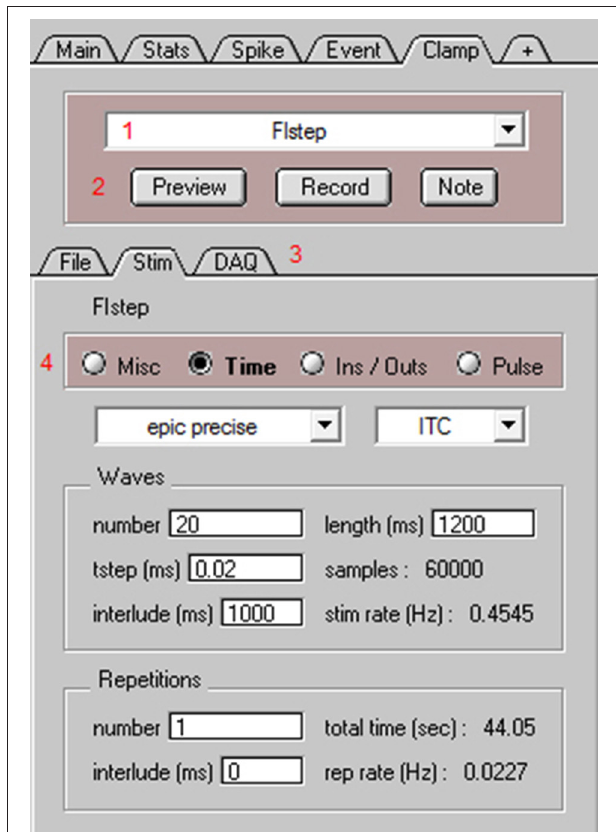
FIGURE 6 | NeuroMatic’s Clamp tab for data acquisition. Screen capture of the bottom of NeuroMatic’s main control panel after activating the Clamp tab ( Figure 2 , control 7). The Clamp tab is used to create input/output configurations for either NI-DAQ or ITC devices, and to create and execute stimulus protocols for data acquisition. Red numbers denote controls of interest: (1) the stimulus select for specifying which stimulus protocol to activate (e.g., FIstep), or to perform a stimulus function such as Open, Save, New, Copy; (2) the Preview and Record buttons for executing the